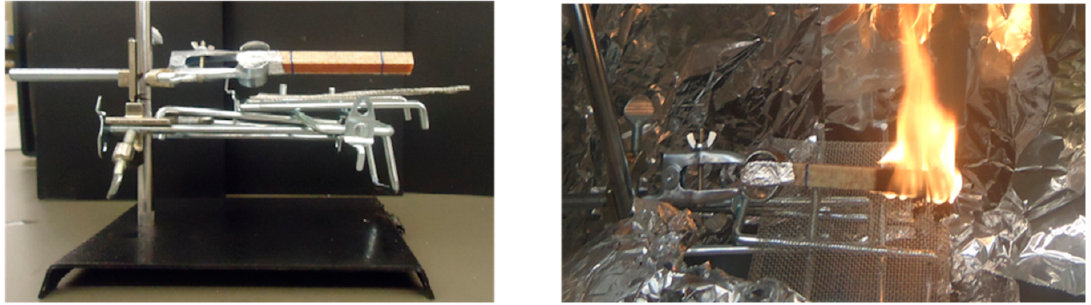
Figure 3. Test setup for determining flame propagation rate.